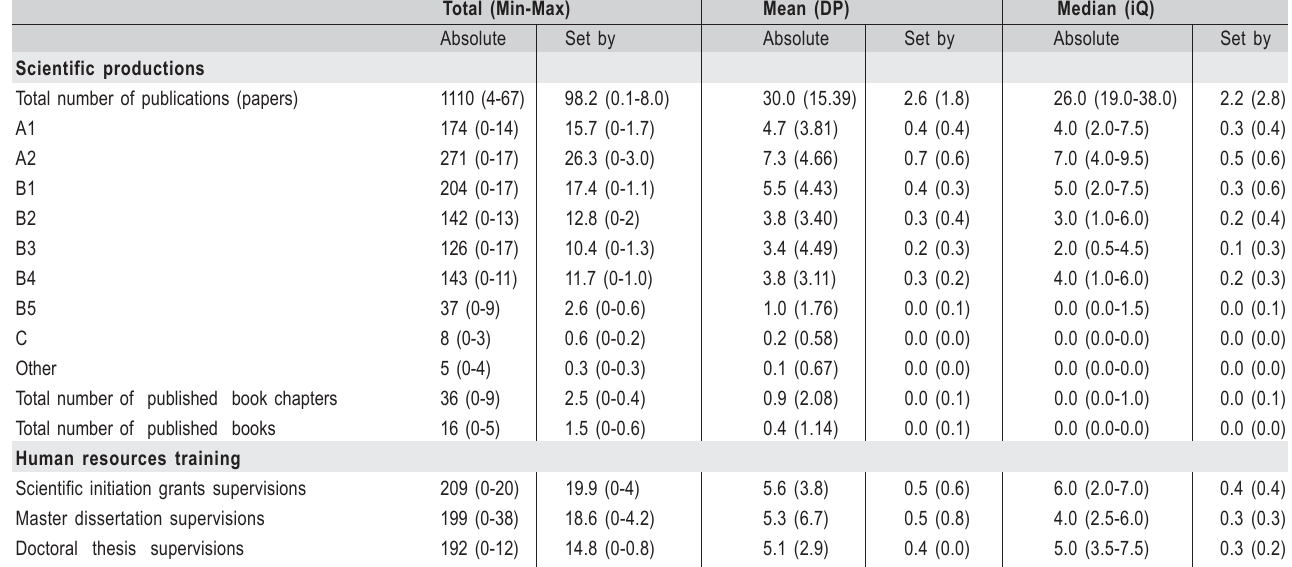
Table 3. Descriptive analysis of scientific production and supervisions of CNPq dental material researchers in absolute numbers and set by year of completion of PhD program.